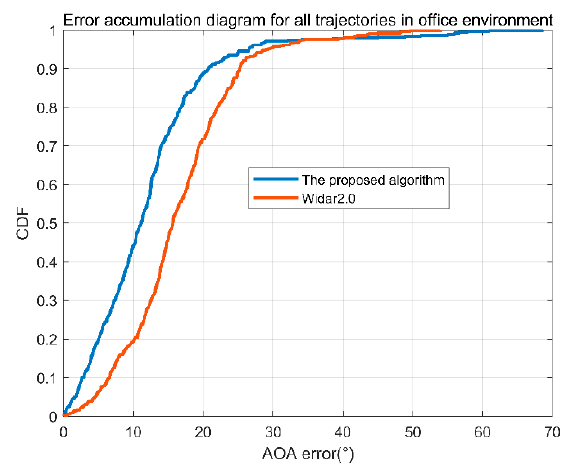
Figure 12. Cumulative angle error of the office.